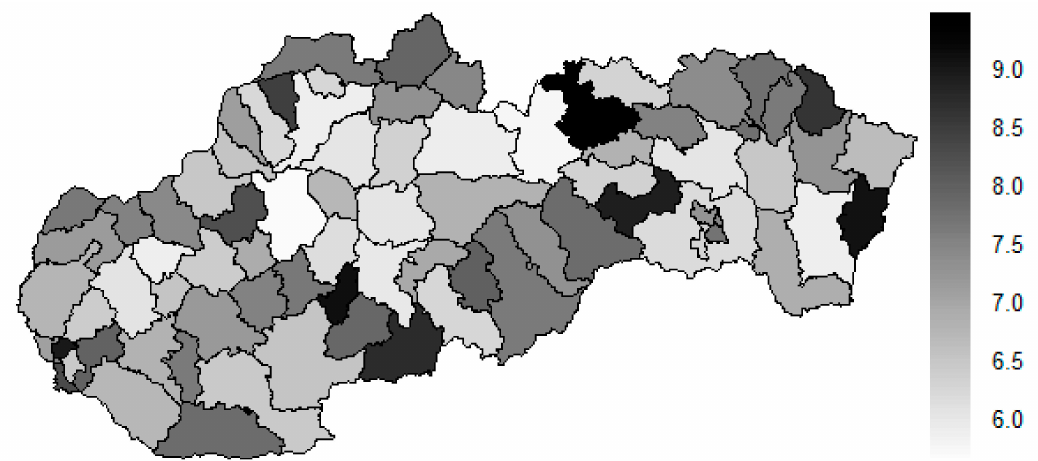
Figure 30. Preventable mortality similarity map of the districts for the male sex in the whole explored period. Source: own elaboration by the